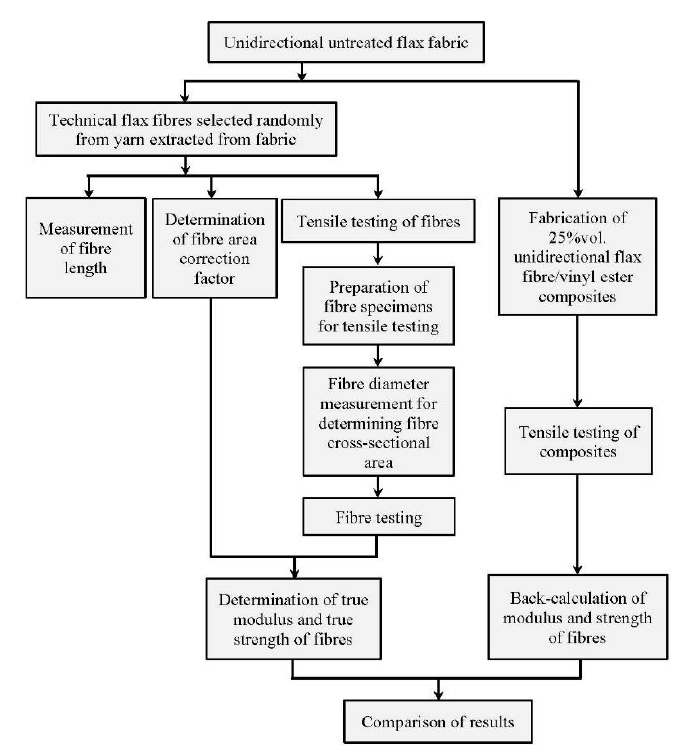
Figure 1. Flowchart of procedure.